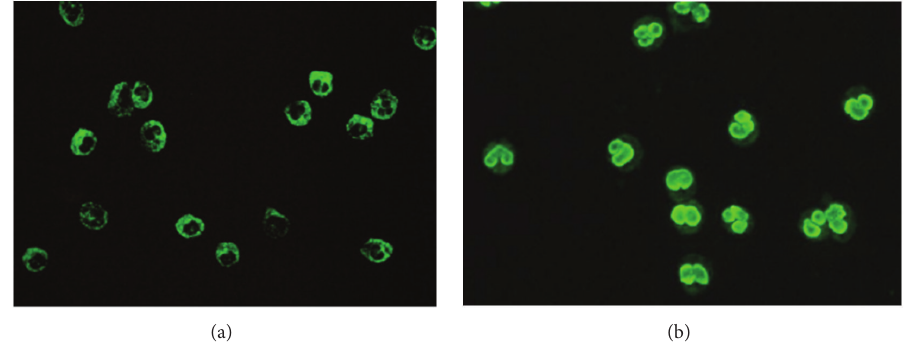
Figure 1: Appearance of cytoplasmic indirect immunofluorescence pattern (C-ANCA, Figure 1(a)) and perinuclear (P-ANCA, Figure 1(b)) on ethanol-fixed human neutrophil cells. The C-ANCA pattern is largely caused by autoantibodies targeting serine protease proteinase-3 (PR3-ANCA), while the P-ANCA pattern is caused by antibodies binding to many antigens among which myeloperoxidase (MPO-ANCA) is the most frequent target in primary systemic vasculitis [11].